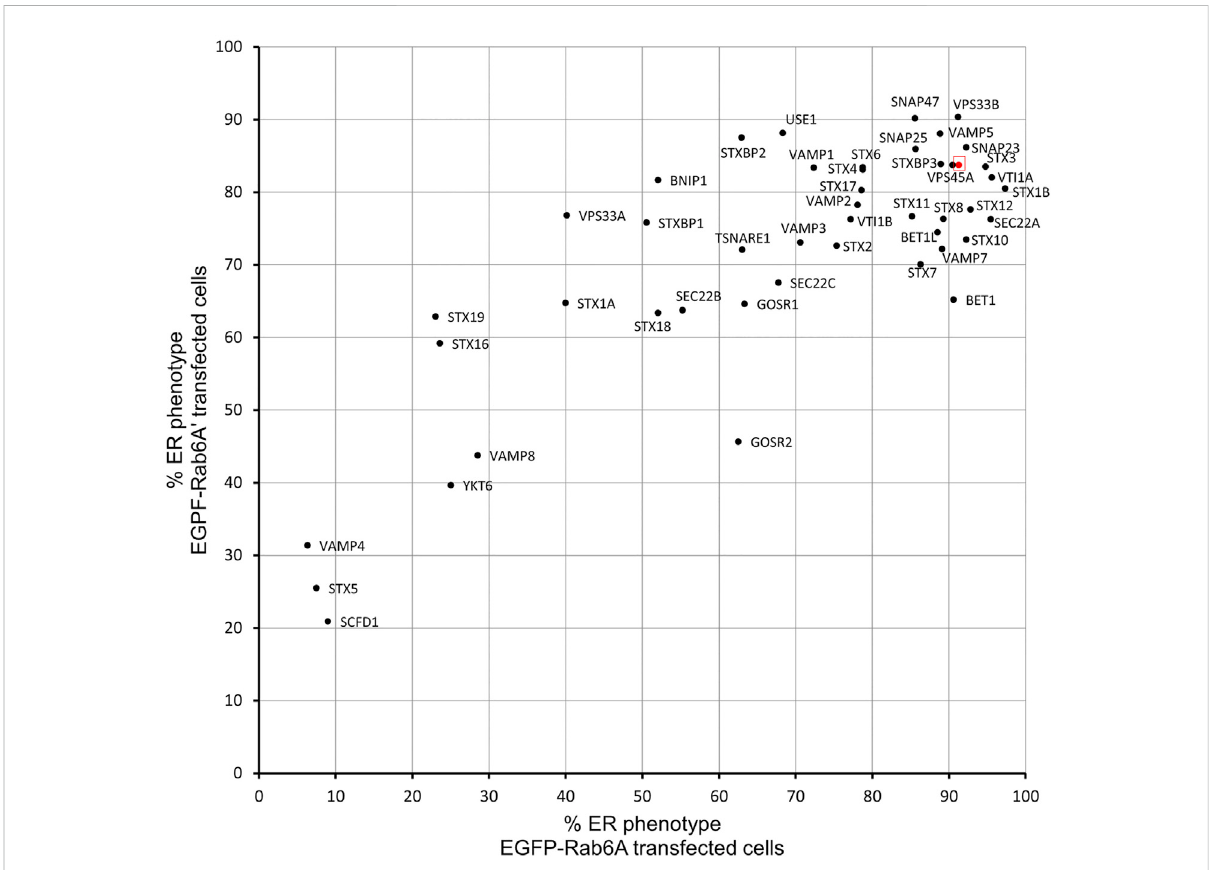
FIGURE 2 Comparison of EGFP-Rab6A and EGFP-Rab6A ′ redistribution assays. Scatterplot showing the percentage of ER phenotypes in the population after each SNARE or SNARE-like protein depletion and BFA treatment in EGFP-Rab6A and EGFP-Rab6A ′ expressing cells. The x-axis represents the percentage of ER phenotypes resulting from each depletion in EGFP-Rab6A transfected cells and the y-axis represents the percentage of ER phenotypes resulting from each depletion in EGFP-Rab6A ′ transfected cells. The highlighted red dot represents the result from negative (NEG) control transfected cells. Pearson ’ s coef fi cient is